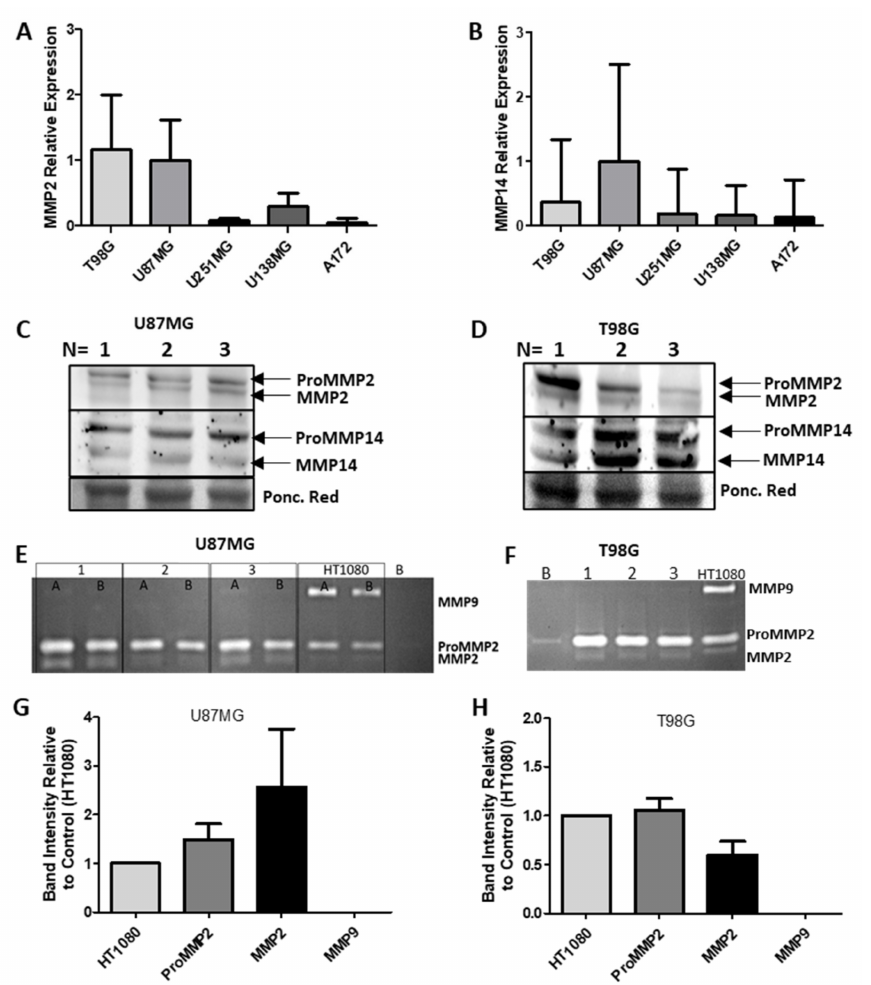
Figure 9. MMP expression in GBM cell lines. ( A ) MMP2 expression in T98G, U87MG, U138MG, U251MG and A172 GBM cell lines; ( B ) MMP14 expression in T98G, U87MG, U138MG, U251MG and A172 GBM cell lines; ( C ) Western blot of MMP2 and MMP14 protein expression in U87MG cells-proMMP2 (72 kDa), MMP2 (62 kDa), proMMP14 (63 KDa), MMP14 (60 KDa) normalized to Ponceau Red staining of the same membrane; ( D ) Western blot of MMP2 and MMP14 protein expression in T98G cells–proMMP2 (72 kDa), MMP2 (62 kDa), proMMP14 (63 KDa), MMP14 (60 KDa) normalized to Ponceau Red staining of the same membrane; ( E ) Gelatin zymography for MMP2 and MMP9 in U87MG; ( F ) Gelatin zymography for MMP2 and MMP9 in T98G; ( G ) Zymogram quantification of U87MG MMP activity relative to HT1080 positive control for MMP2 and MMP9 activity; ( H ) Zymogram quantification of T98G MMP activity relative to HT1080 positive control for MMP2 and MMP9 activity. Images in C and D are the DMSO controls presented in Figure 11. Data are presented as mean + SEM, n = 3. Part of these data have been published in